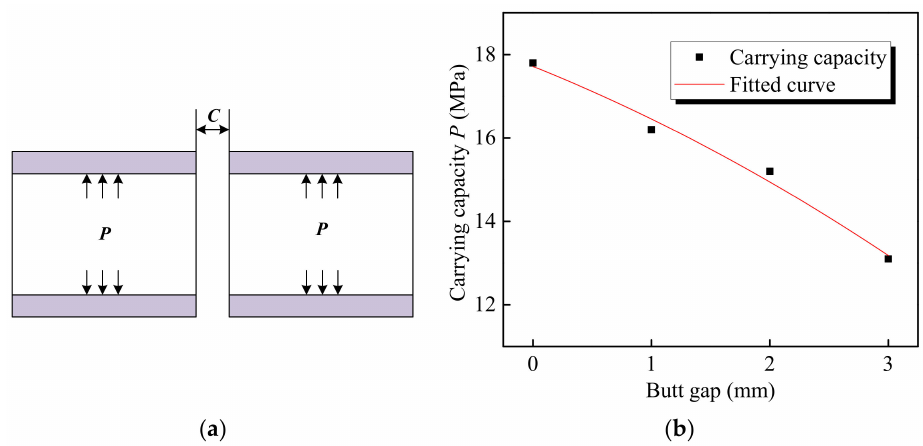
Figure 18. Relationship between carrying capacity and butt gap: ( a ) schematic diagram of pipeline bearing internal pressure; ( b ) curve fitting of carrying